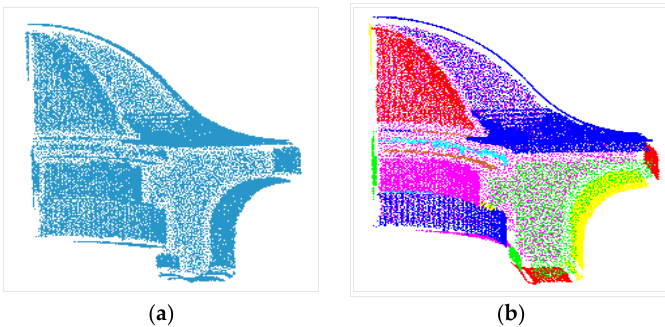
Figure 6. Comparison of results before and after patch classification: ( a ) original points display and ( b ) classification display.